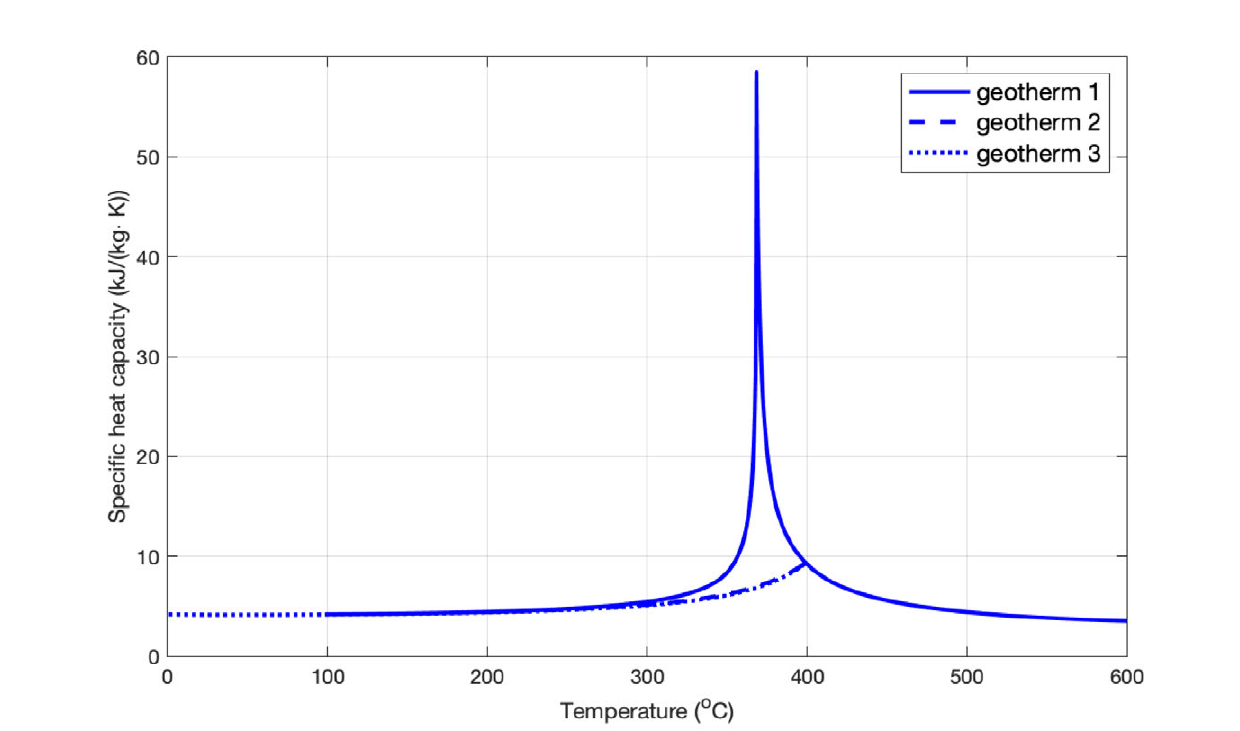
Figure D6: Specific heat capacity of water as a function of temperature for the same 3 geotherms as in Figure D5. Data from Parry et al.